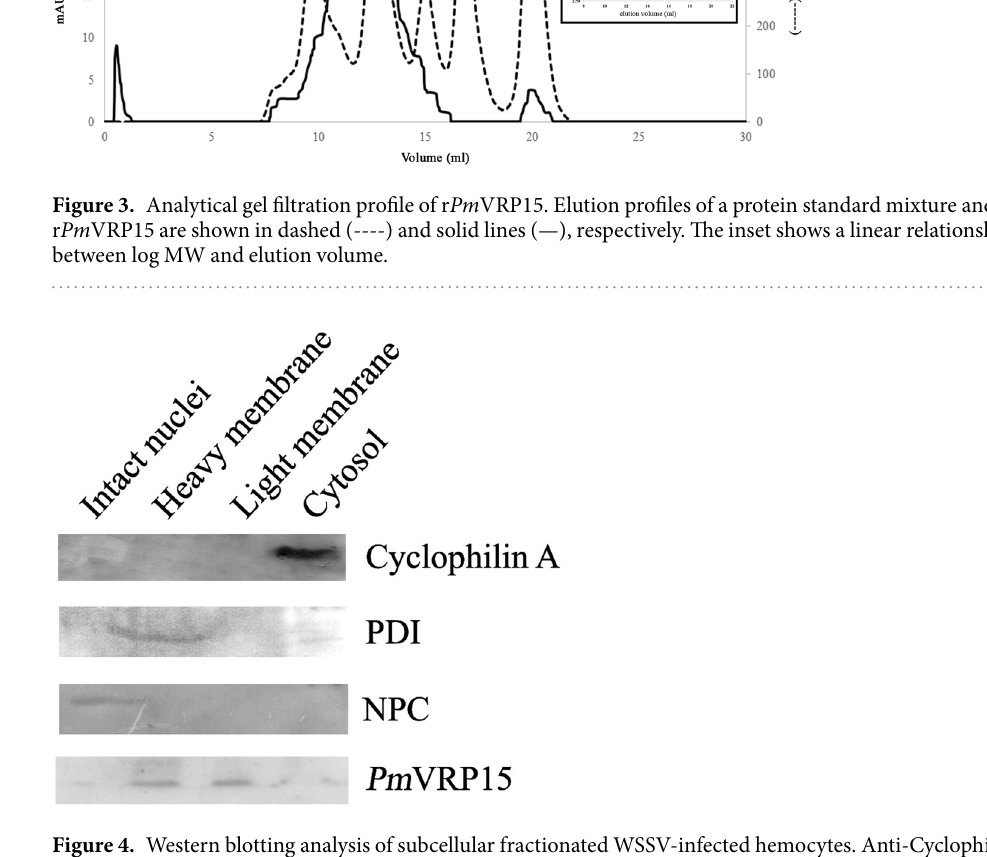
Figure 4. Western blotting analysis of subcellular fractionated WSSV-infected hemocytes. Anti-Cyclophilin A, PDI and NPC antibodies were used as cytosol, ER and nuclear markers, respectively. The blots shown here are cropped from full-length blots in the Supplementary